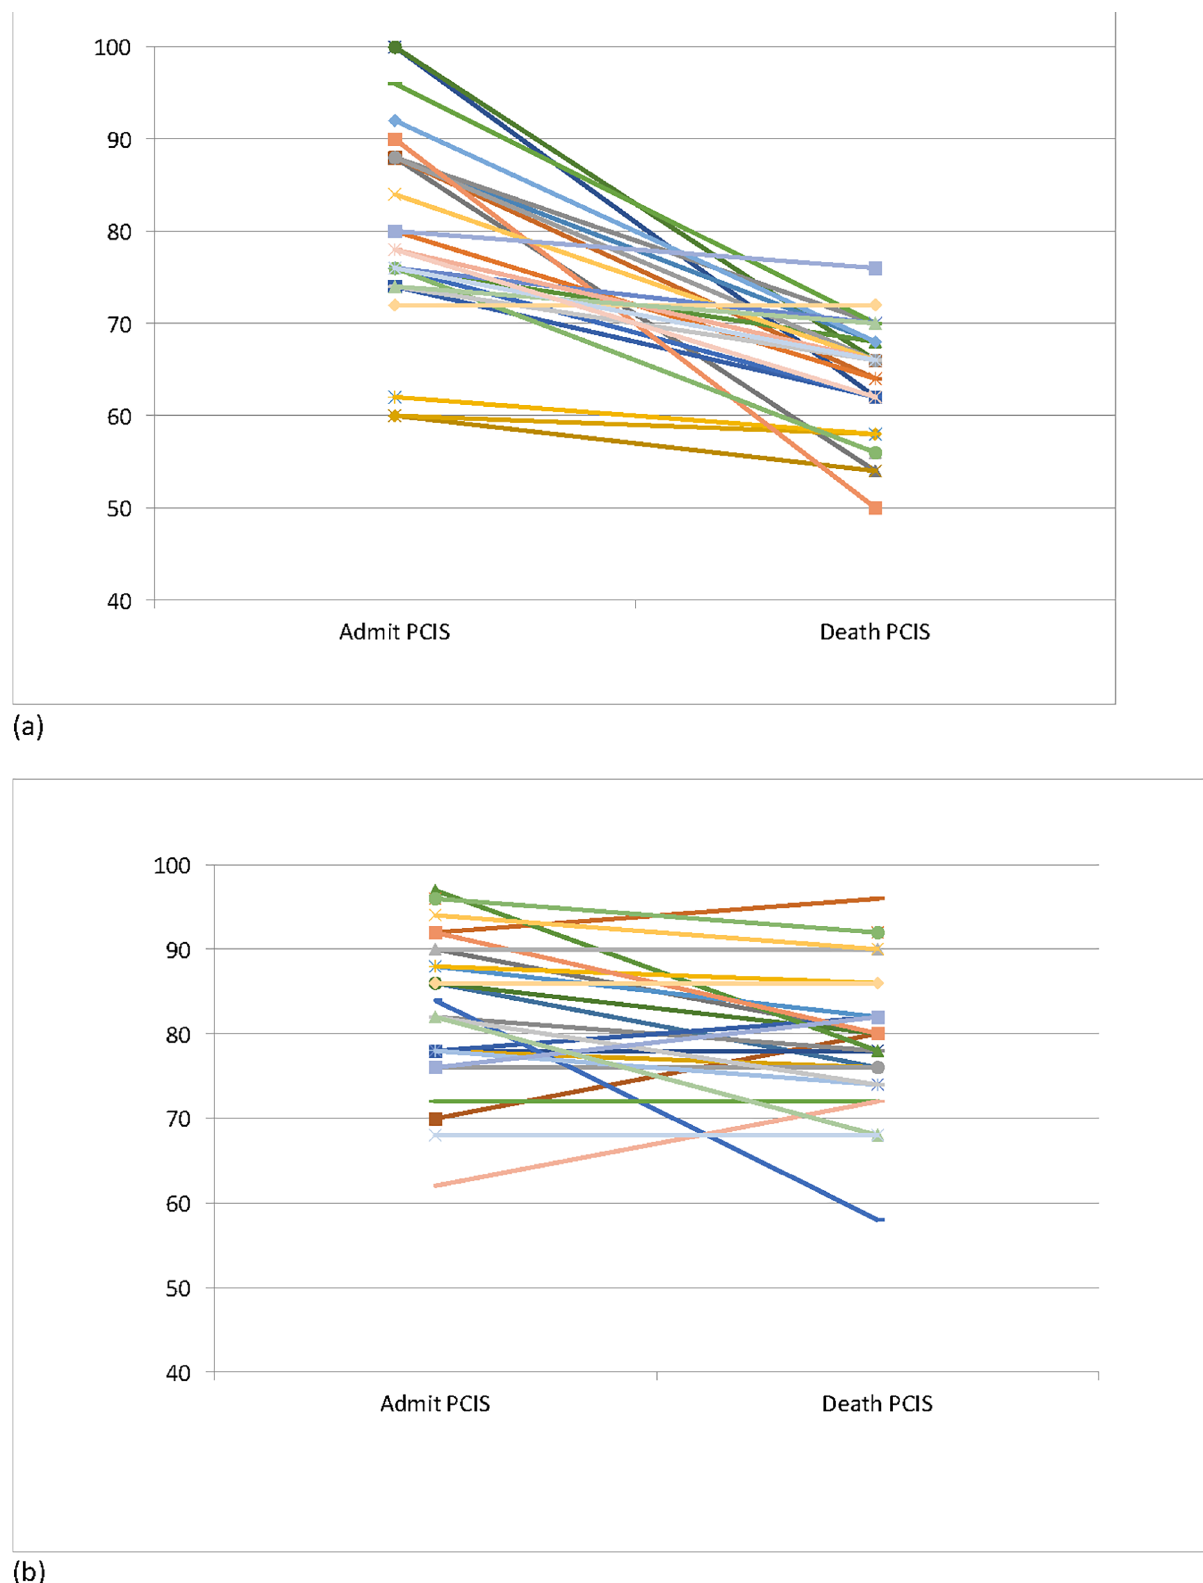
Fig 1. PCIS at admission and death of children. Each line represents one patient. Increasing number implies clinical improvement.